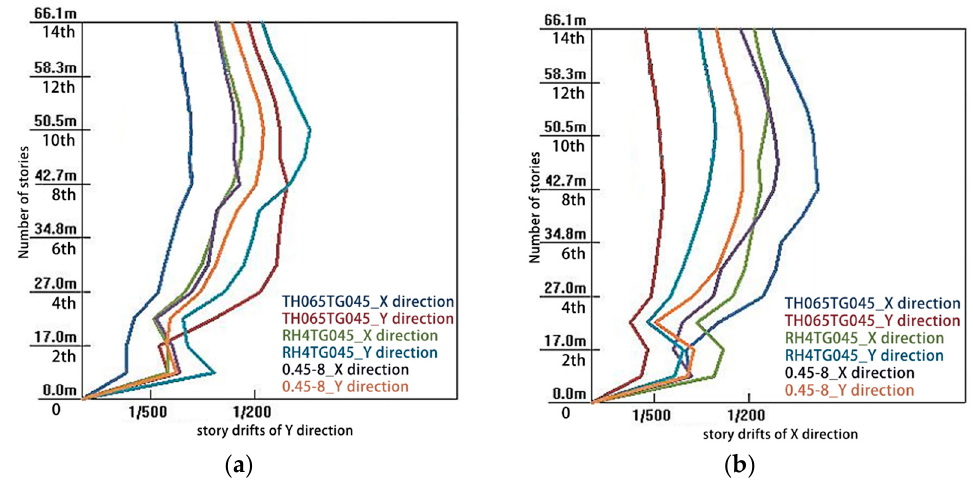
Table 17. The maximum values of the storey drifts under the three earthquake waves .